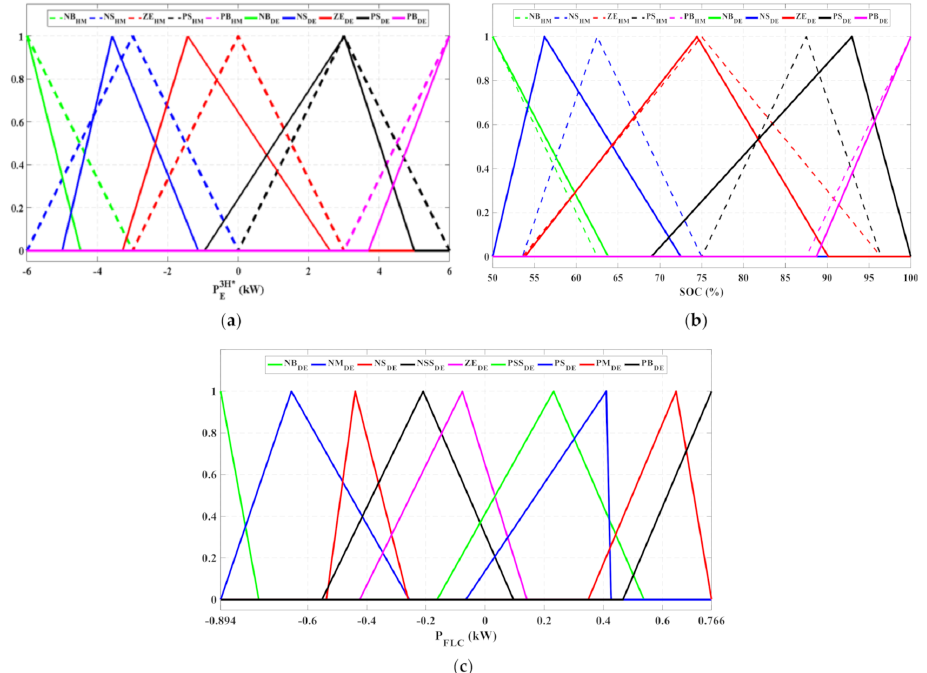
Figure 7. Resulting MFs through Differential Evolution (DE) algorithm ( a ) input P 3 H ∗